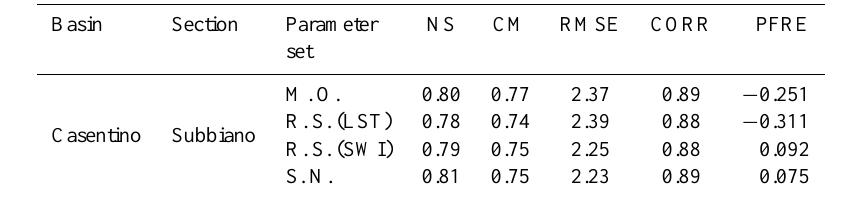
Table 10. The Casentino basin skill scores on hydrographs on the entire validation period (2005–2011) for the different parameter sets. The scores value is calculated for the Subbiano section. PFRE is calculated with Q th = 200m 3 s − 1 .